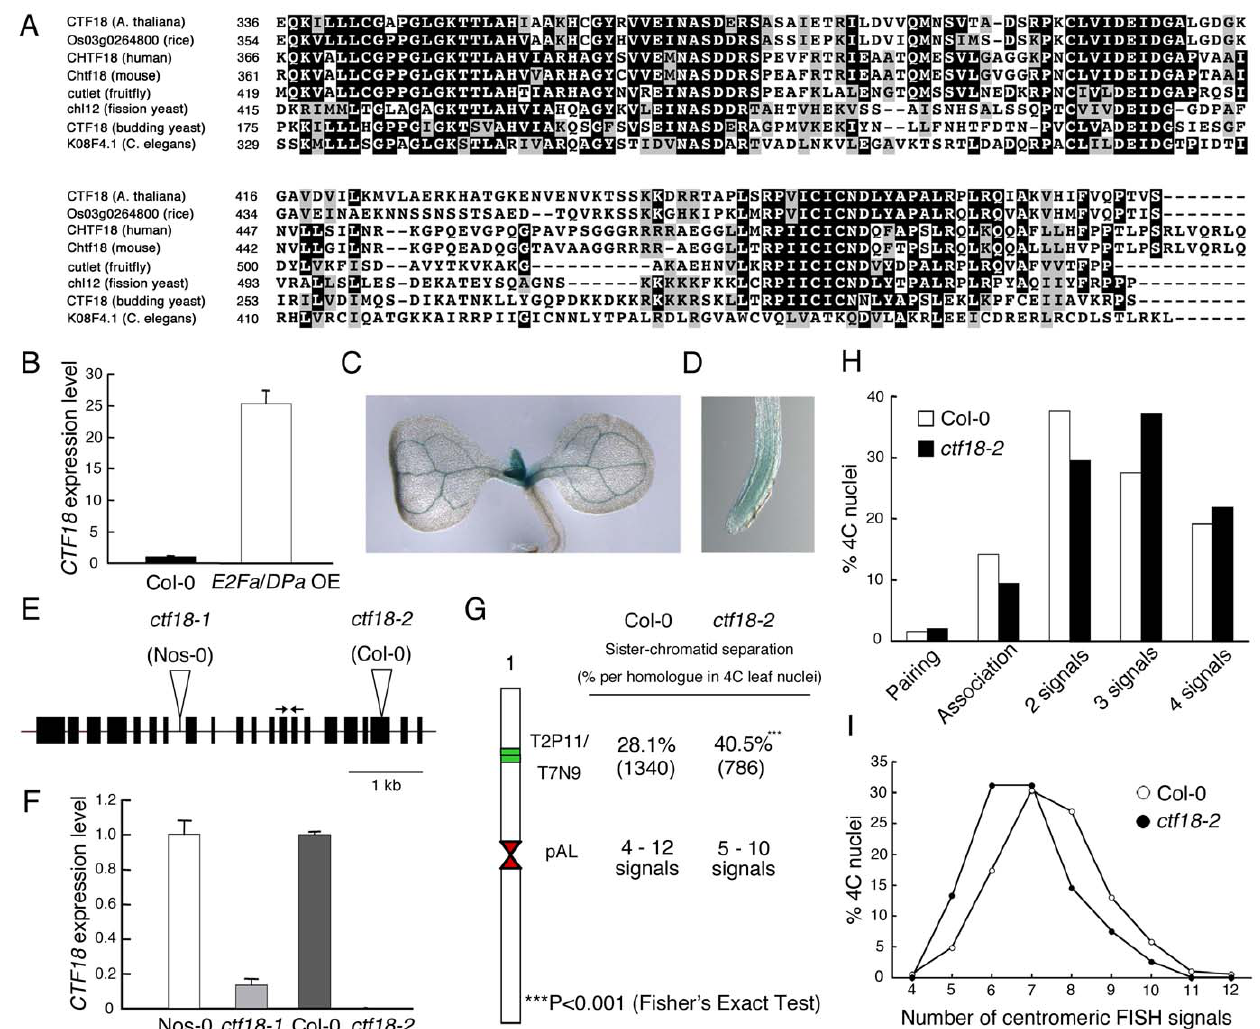
Figure 3. Importance of Arabidopsis CTF18 for sister chromatid cohesion. (A) Alignment of the AAA domain of CTF18 with its orthologous proteins: CHTF18 (NP_071375; human), Chtf18 (NP_663384; mouse), cutlet (NP_787969; fruitfly), Os03g0264800 (rice), CTF18 (NP_013795; budding yeast), chl12 (NP_595200; fission yeast), and K08F4.1 (NP_501841; C. elegans ). (B) Real-time RT-PCR analysis of CTF18 expression in wild-type (WT; Col- 0) and E2Fa - DPa -overexpressing (E2Fa/DPa OE ) plants. Total RNA prepared from 6-day-old plants was amplified by RT-PCR. All values were normalized against the expression level of the ACTIN2 gene. (C,D) Histochemical localization of the GUS activity in transgenic 7-day-old shoot (C) and root (D) carrying the CTF18 promoter. (E) Exon (boxes) and intron (lines) structure of CTF18 . White triangles and arrows indicate T-DNA insertion sites and primer positions used for real-time RT-PCR analysis, respectively. (F) Real-time RT-PCR analysis of CTF18 expression in wild-type (Nos-0 and Col-0), ctf18-1 , and ctf18-2 plants. Total RNA prepared from 9-day-old plants was amplified by RT-PCR. All values were normalized against the expression level of the ACTIN2 gene. (G) Positional sister arm separation frequency detection by FISH detecting , 100 kb mid-arm segments (BACs T2P11 and T7N9) and centromeric signal number detected by the 178-bp pAL probe. (H) Percentage of sister chromatid alignment/separation frequencies analyzed in wild-type (Col-0) and ctf18-2 after FISH with labeled BACs T2P11 and T7N9 from chromosome 1. (I) Similar frequencies of centromere-specific FISH signals in wild-type and ctf18-2